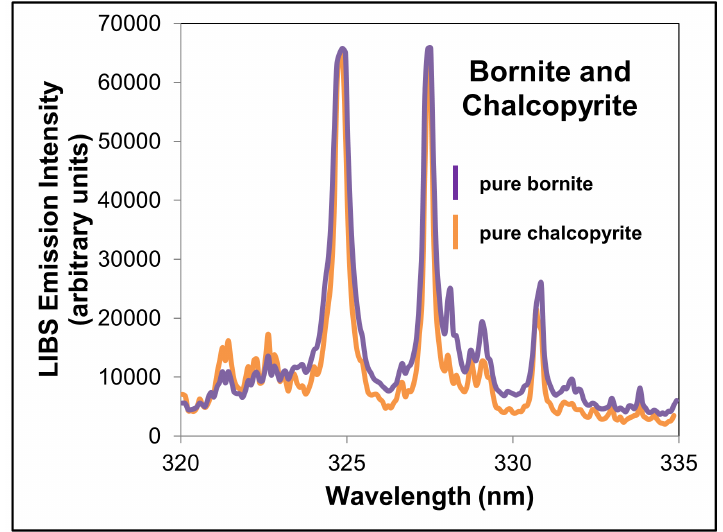
Figure 17. LIBS spectra of the chalcopyrite and bornite standards over the wavelength interval of 335–370 nm. The Cu spectral lines at 324.75 nm and Cu 327.40 nm were selected, and a background value was taken at 329.90